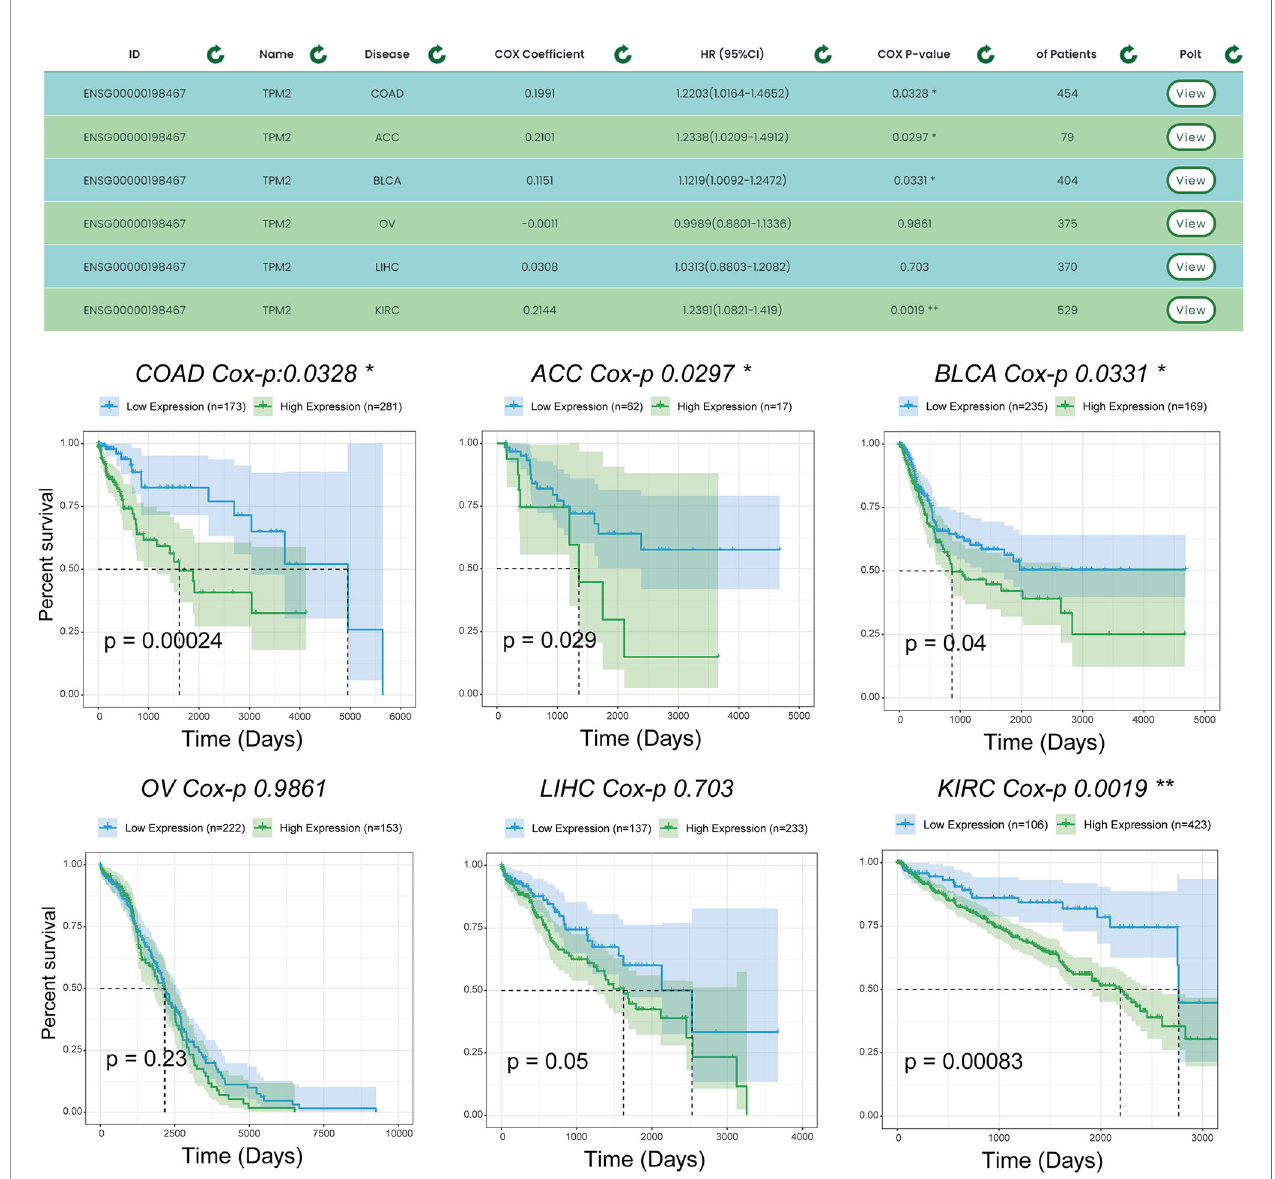
FIGURE 6 | Survival analysis results for TPM2 in multiple datasets. Users can analyze the survival of a gene for pancreatic cancer using the single gene-multiple disease function. “ * ” indicates p-value <0.05, “ ** ” indicates p-value